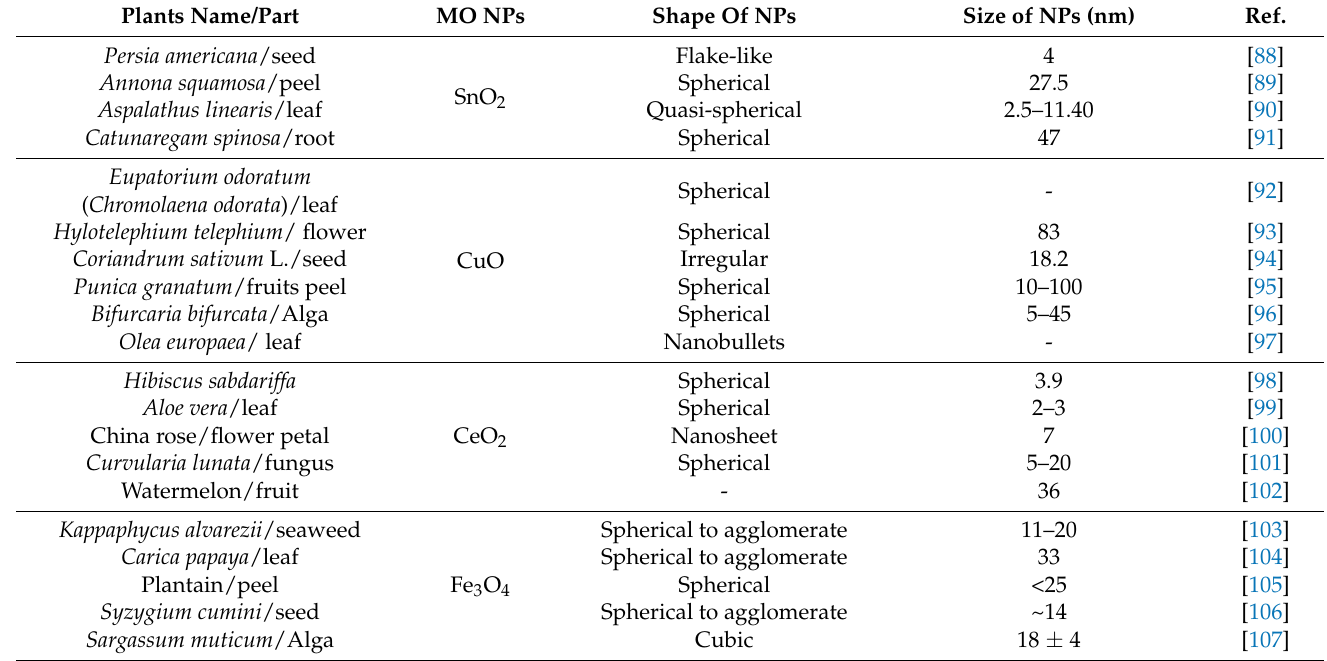
Table 4. Synthesis of metal oxide nanoparticles (MO NPs) from various bio